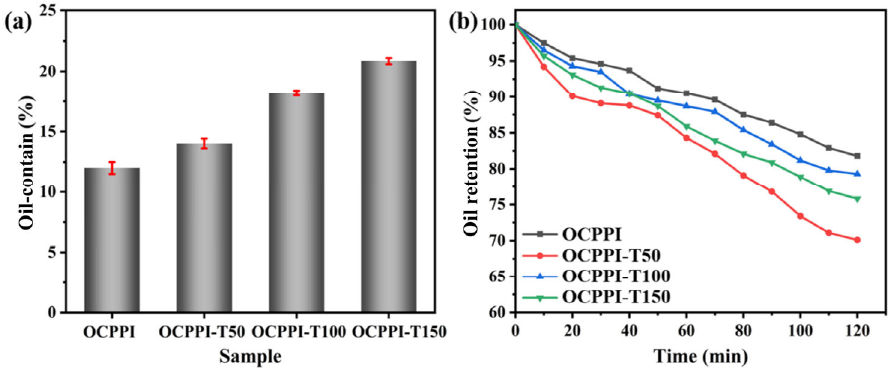
Fig. 4 Oil-content and oil-retention of different samples.